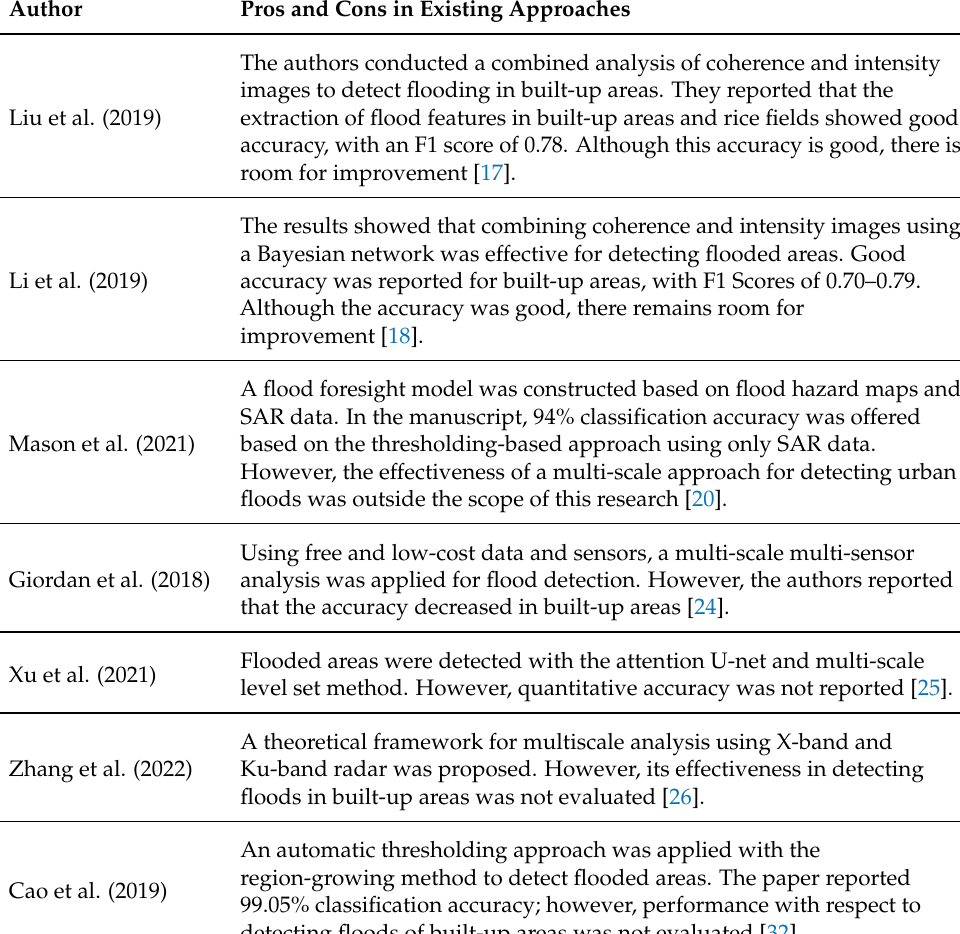
Table 1. Pros and Cons of existing